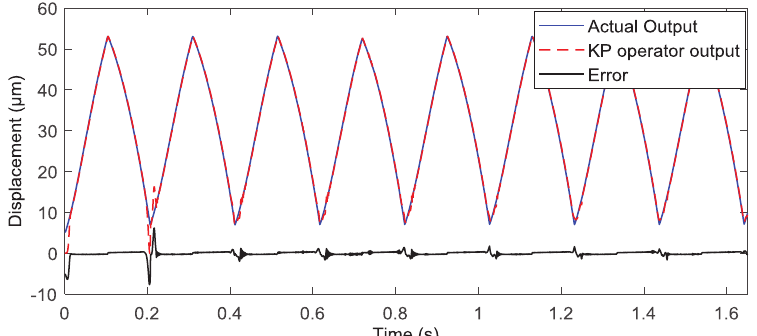
Figure 6. Experimental result of KP operator based on the gradient descent algorithm under the triangular wave voltage signal.